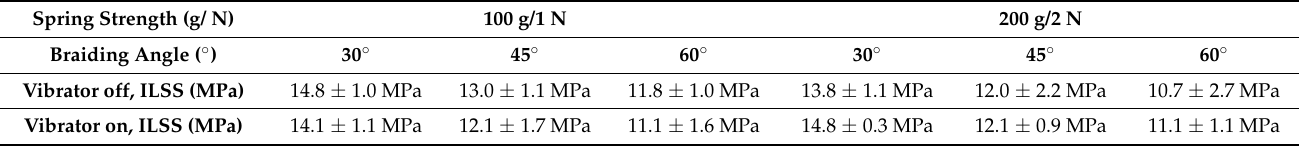
Table 4. Influence of spring tension, braiding angle and vibrator setting on the interlaminar shear strength. Spring Strength (g/ N) Braiding Angle ( ◦